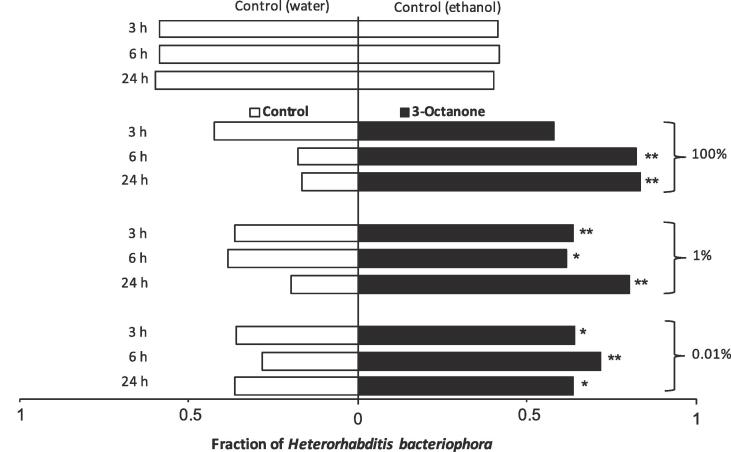
The chemotactic response of Heterorhabditis bacteriophora infective juveniles after 3, 6, and 24 hr when offered a choice between 3-octanone (right closed bars) and no odor source (left open bars). Each bar represents the choice of nematodes. *P < 0.05, **P < 0.01.